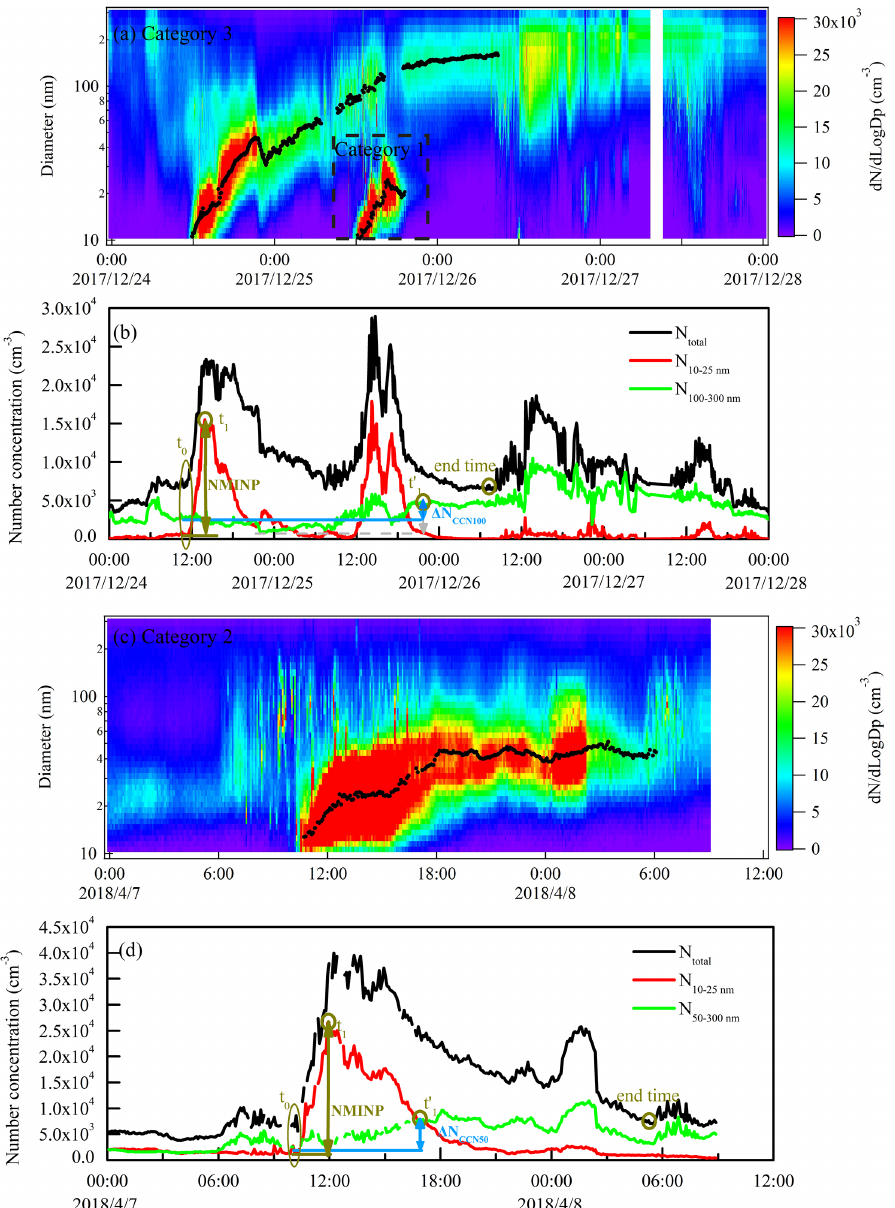
Figure 1. Examples of NPF events in three categories. Black dots in the figures are the fitted D pg . (a) Category 1 on 25 December 2017, in which D pgmax was 24nm ( < 50nm), and Category 3 on 24 December 2017, in which D pgmax grew to 163nm ( > 80nm); (c) Category 2 on 7 April 2018, in which D pgmax grew to 53nm (50–80nm). (b, d) Schematic diagram of t 0 , t 1 , t (cid:48) 24 December 2017 and 7 April 2018 NPF events (a few spikes have been removed from d